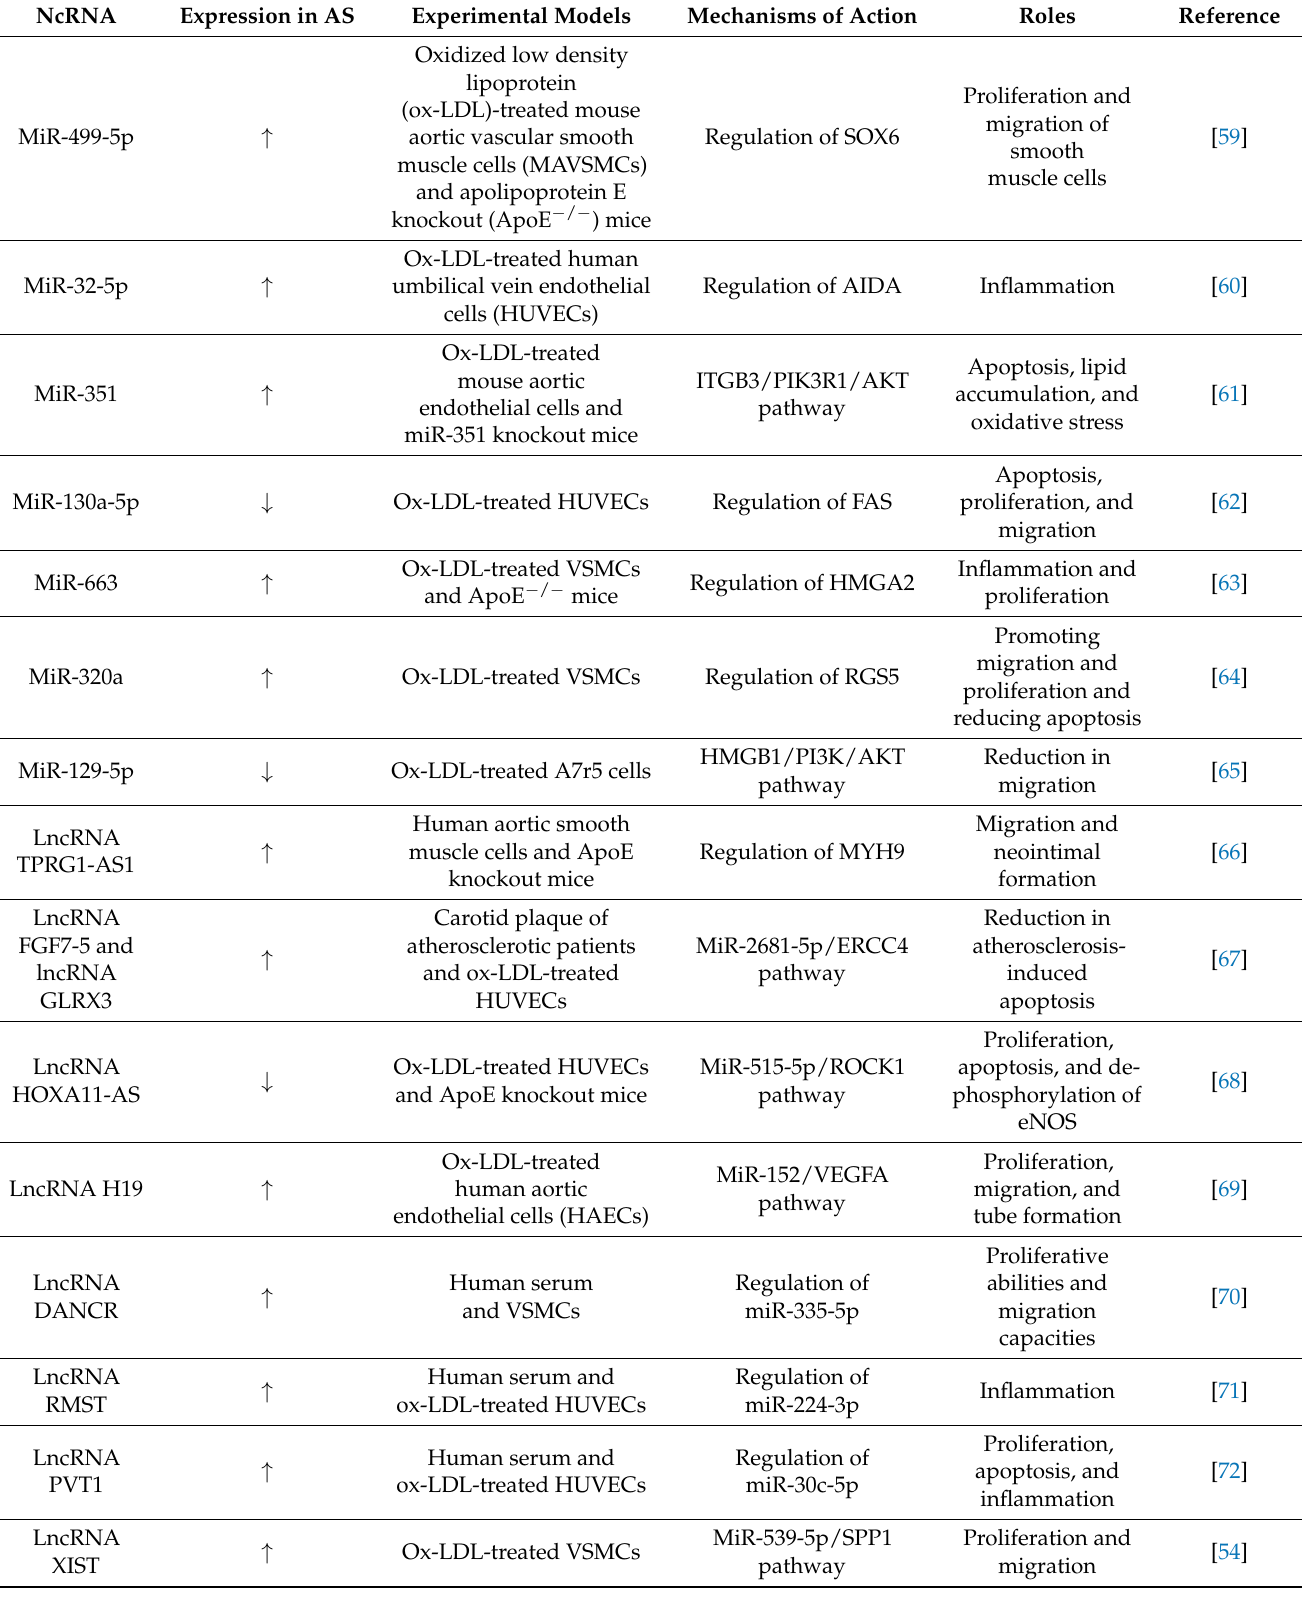
Table 1. Noncoding RNAs in atherosclerosis